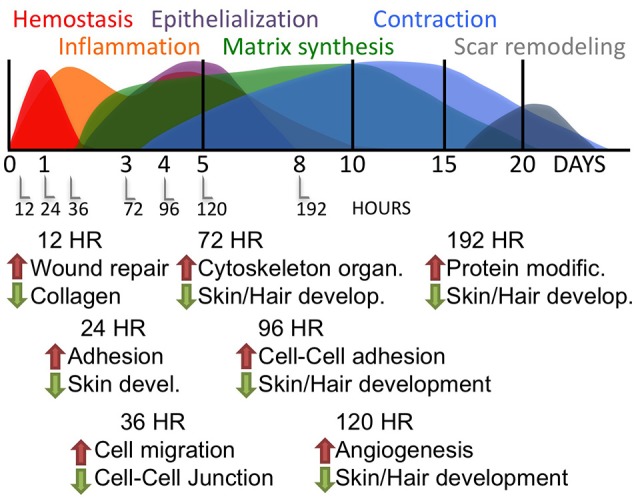
Time-course of RNA response to skin wounds. Upper panel: A graphic summary of the major pathways engaged during mammalian wound repair as adapted from Seifert et al. (2012). Lower panel: The major gene ontologies of the transcripts regulated by wounding of the mouse skin, as detailed in Table 1.